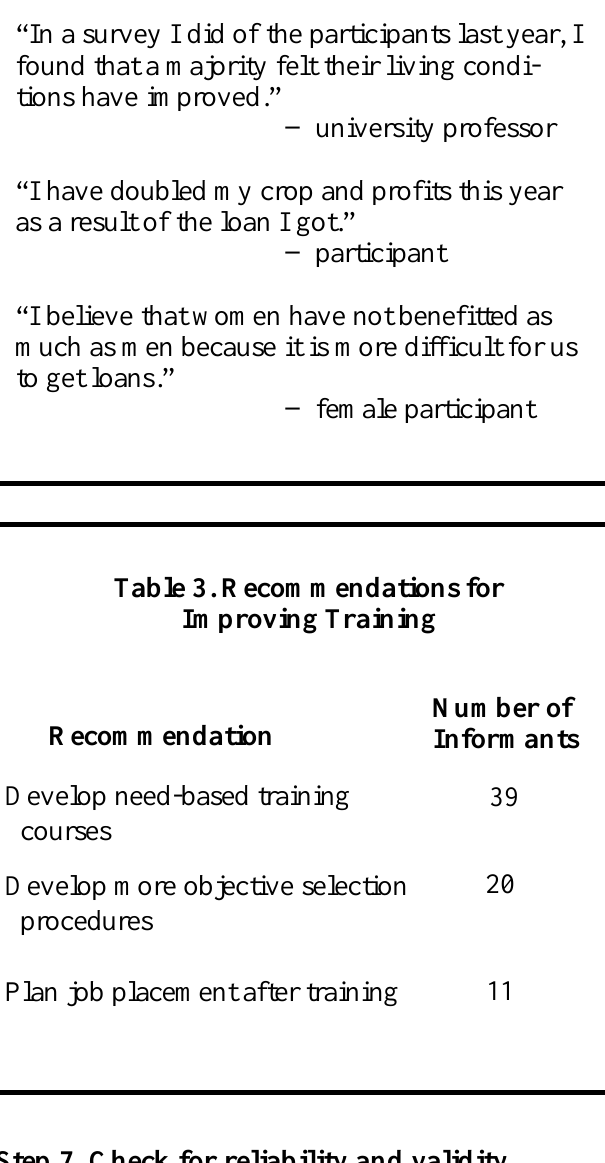
Table 2. Impacts on Income of a Microenterprise